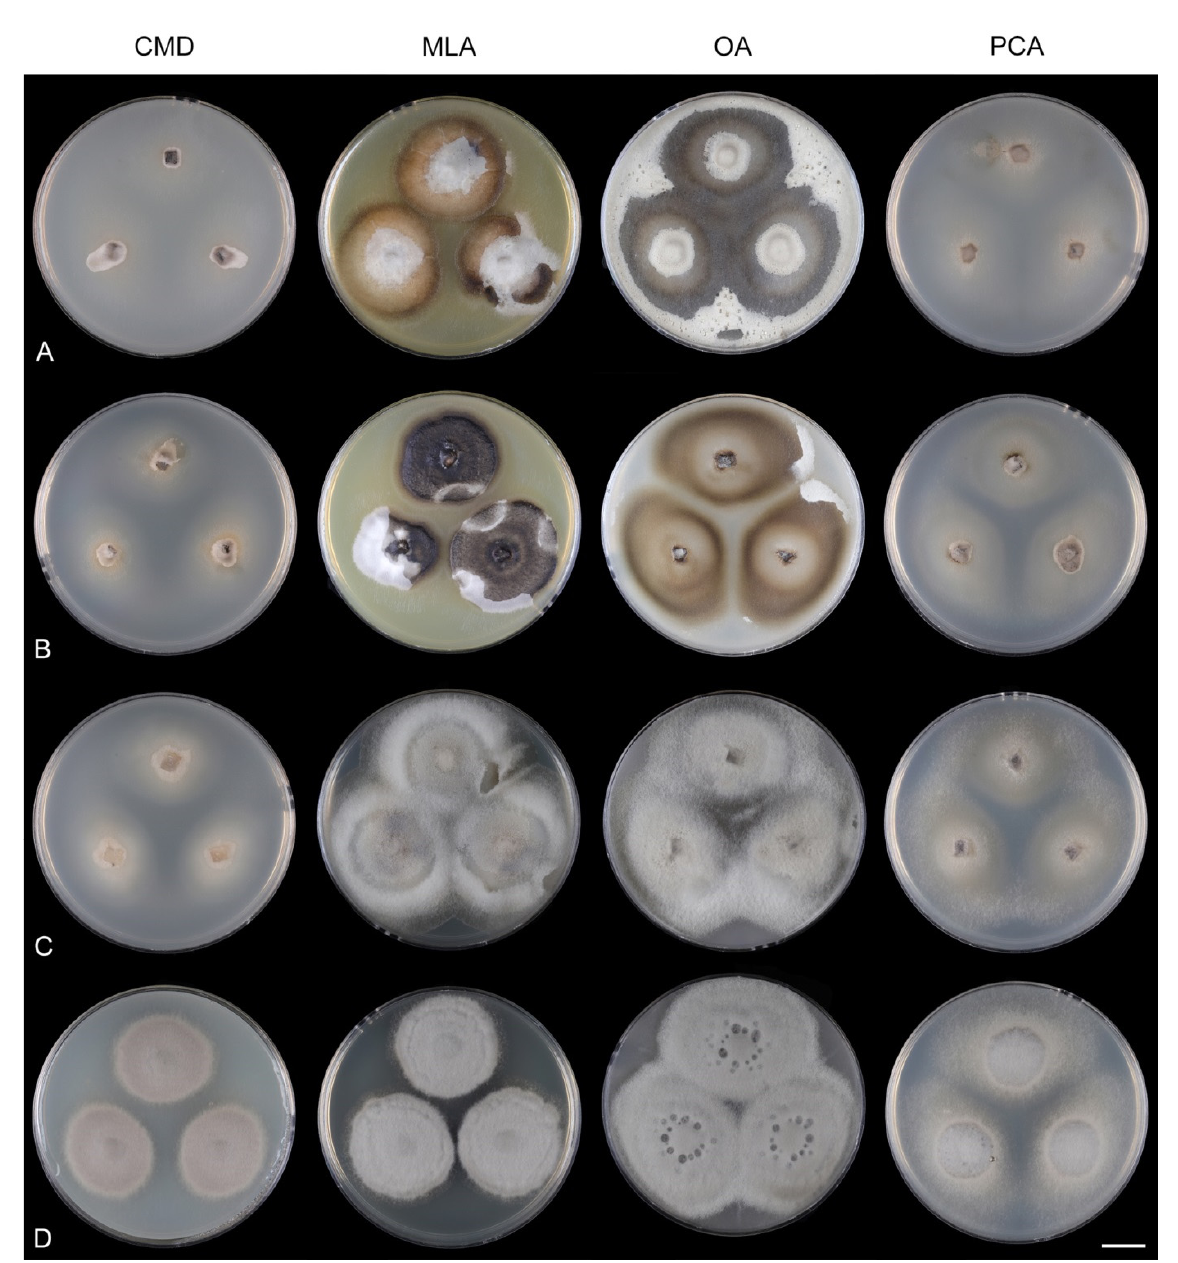
Figure 30. Colony morphology of Codinaeella parvilobata after 4 weeks. ( A ) CBS 144536 ex-type ( B ) CBS 144792 ( C ) CBS 144658 ( D ) MUCL 28054. Scale bar: ( A – D ) 1 cm.